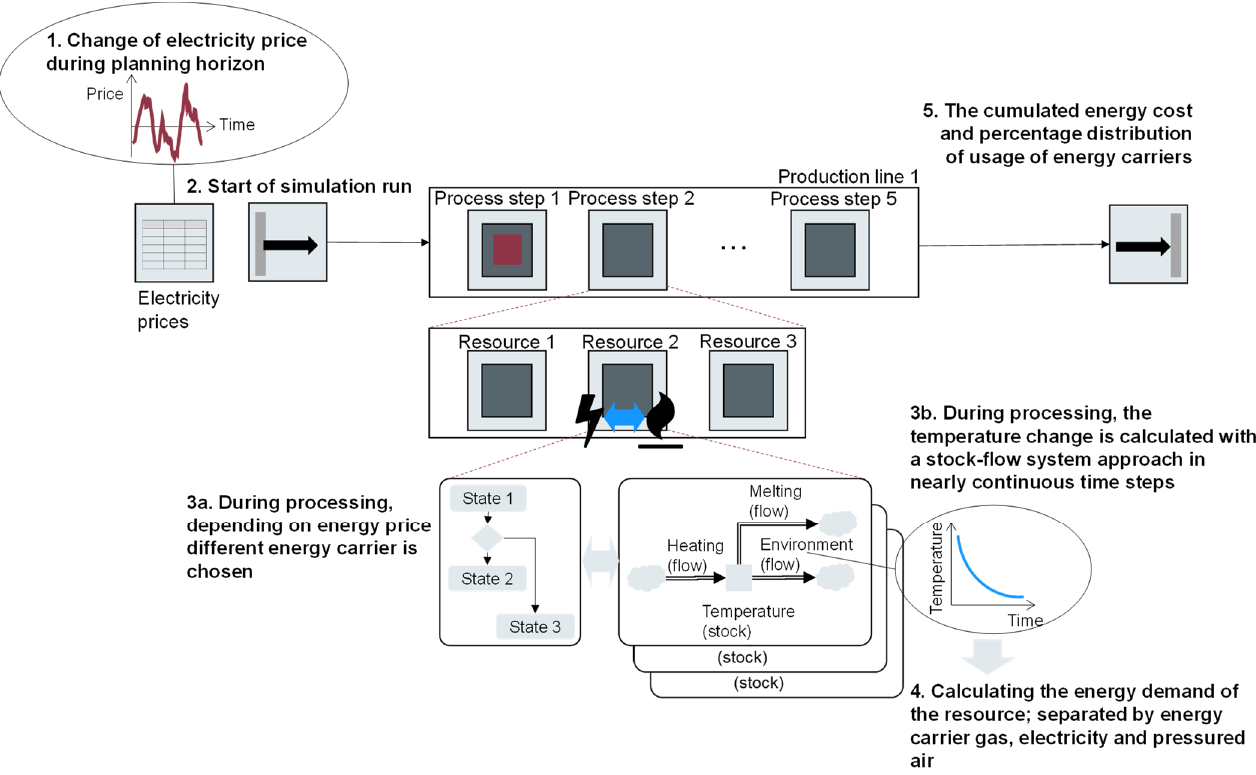
Figure 8. Schematic representation of the material and energy flows in use case 5.